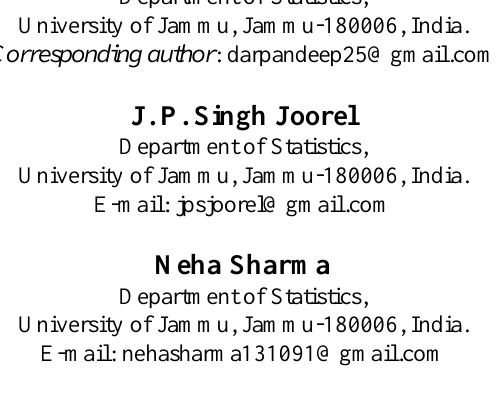
for different values of 𝜇 1